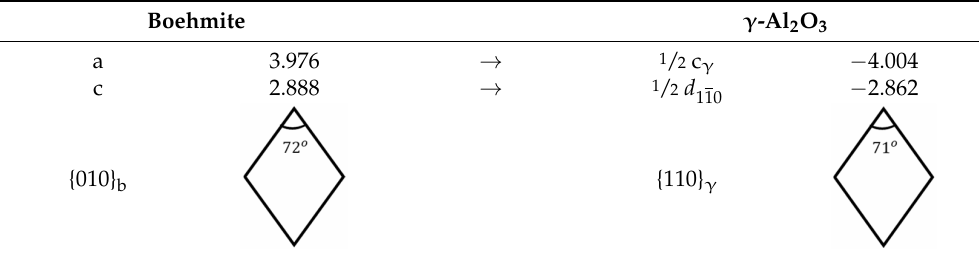
Table A2. SAED results and the associated morphology of boehmite and γ -Al 2 O 3 in this